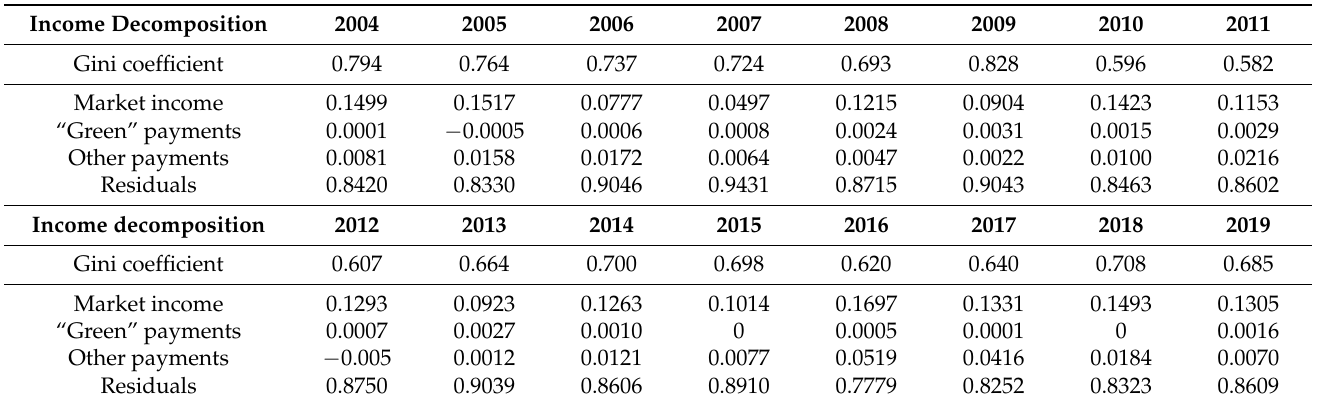
Table 5. Income inequality decomposition for aggregated “green” CAP payments.